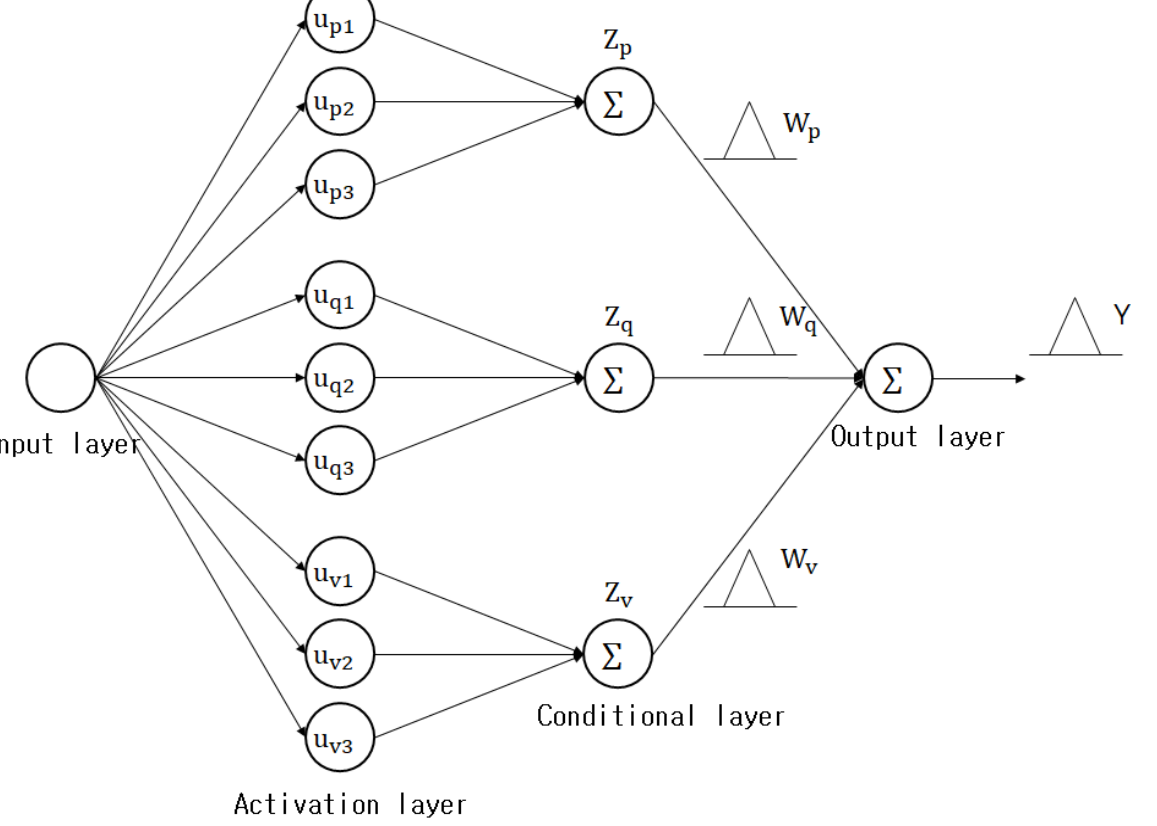
Figure 6. Structure of a fuzzy-based granular model.